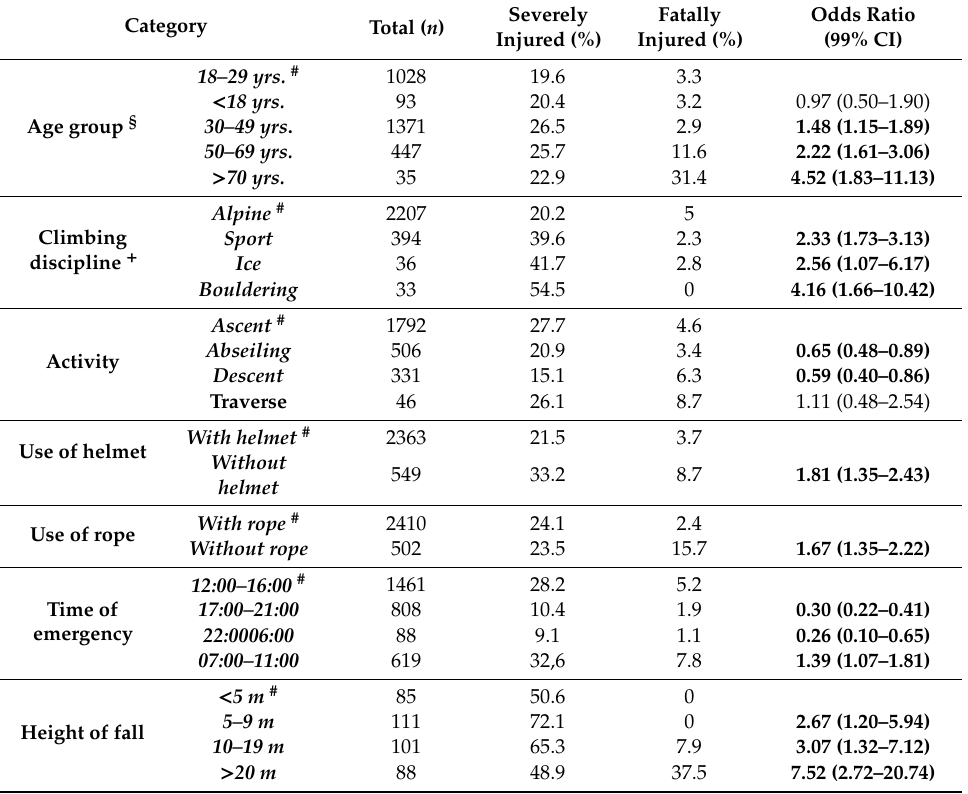
§ Adjusted for the performed climbing discipline only. + Adjusted for age only. # Reference for odds ratio. Odds ratio in bold type indicates statistical